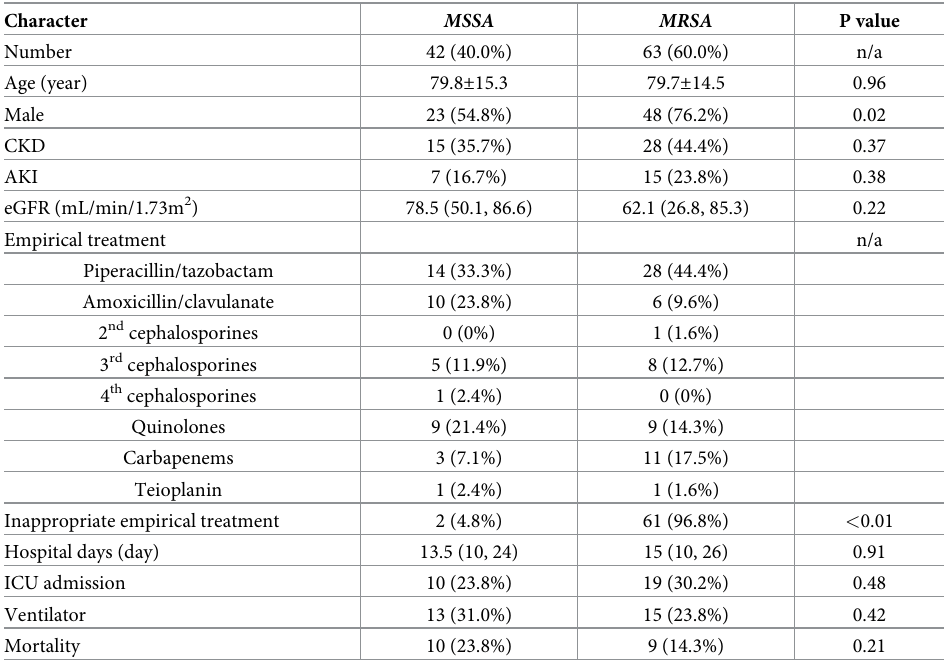
Table 5. Resistance to methicillin of S . aureus and the outcomes of pneumonia patients.